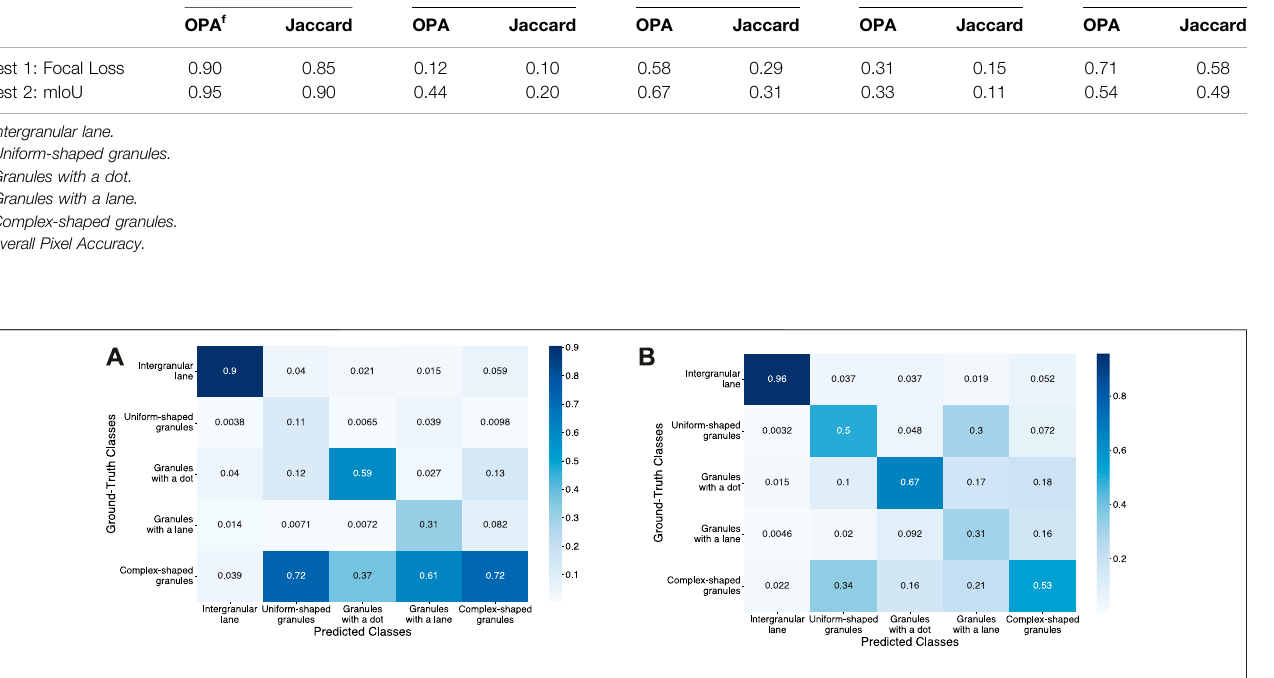
FIGURE6|(A) Probability distribution at pixellevel ofthecategory prediction given its originalcategory (confusion matrix) for test 1: U-net model using α -balanced Focal loss with γ = 10 as training loss function. (B) Probability distribution at pixel level of the category prediction given its original category (confusion matrix) for test 2: U-net model using Mean IoU as training loss